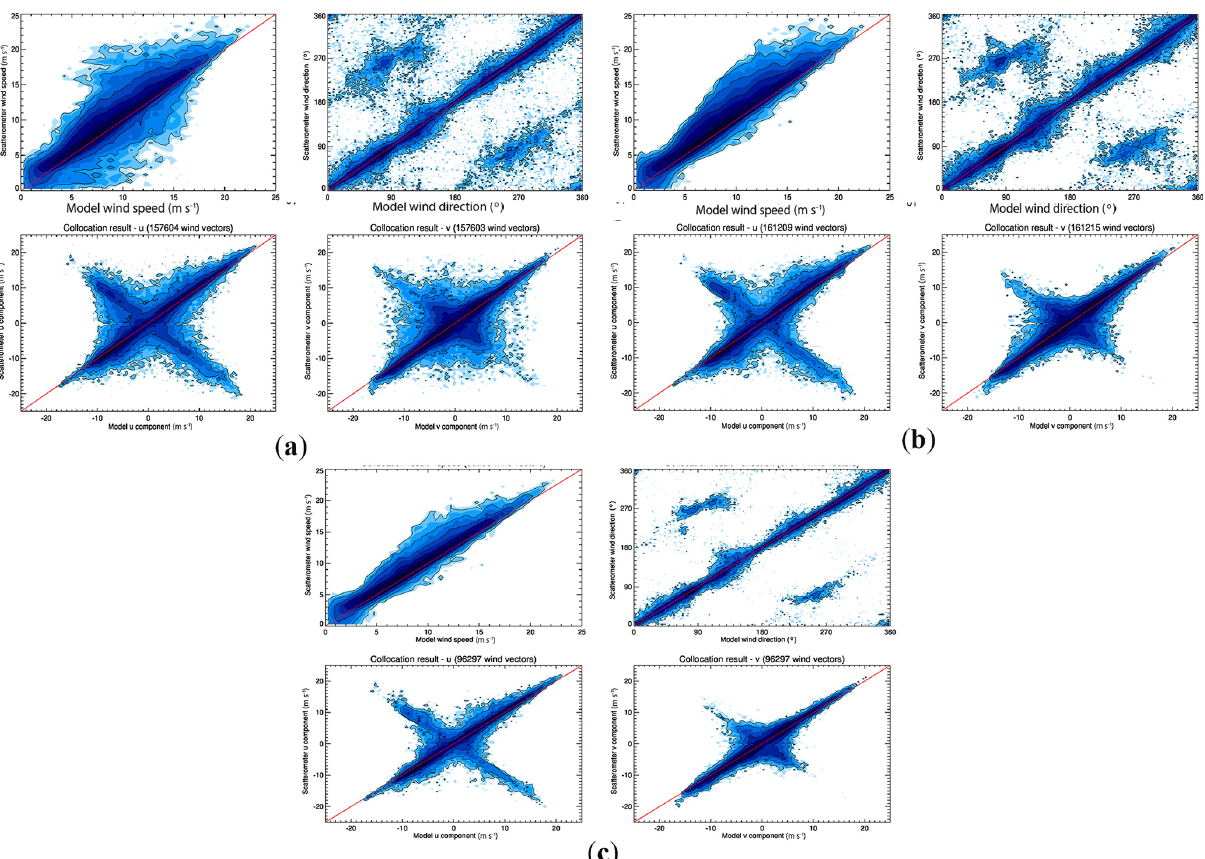
Figure 24. Contoured histograms of SCAT retrieved first rank wind solution (the views with similar azimuth angles are aggregated into one view) versus input wind field for four orbits. (a) All WVCs within the swath; (b) excluding the WVCs in the outer swath, for which WVC numbers from 8 to 42 are included; (c) excluding the WVCs in the outer swath and nadir swath, for which WVC numbers from 8 to 17 and 26 to 42 are included. From (a) to (c) , upper left: wind speed; upper right: wind direction; lower left: u component; lower right: v component. The contour lines are